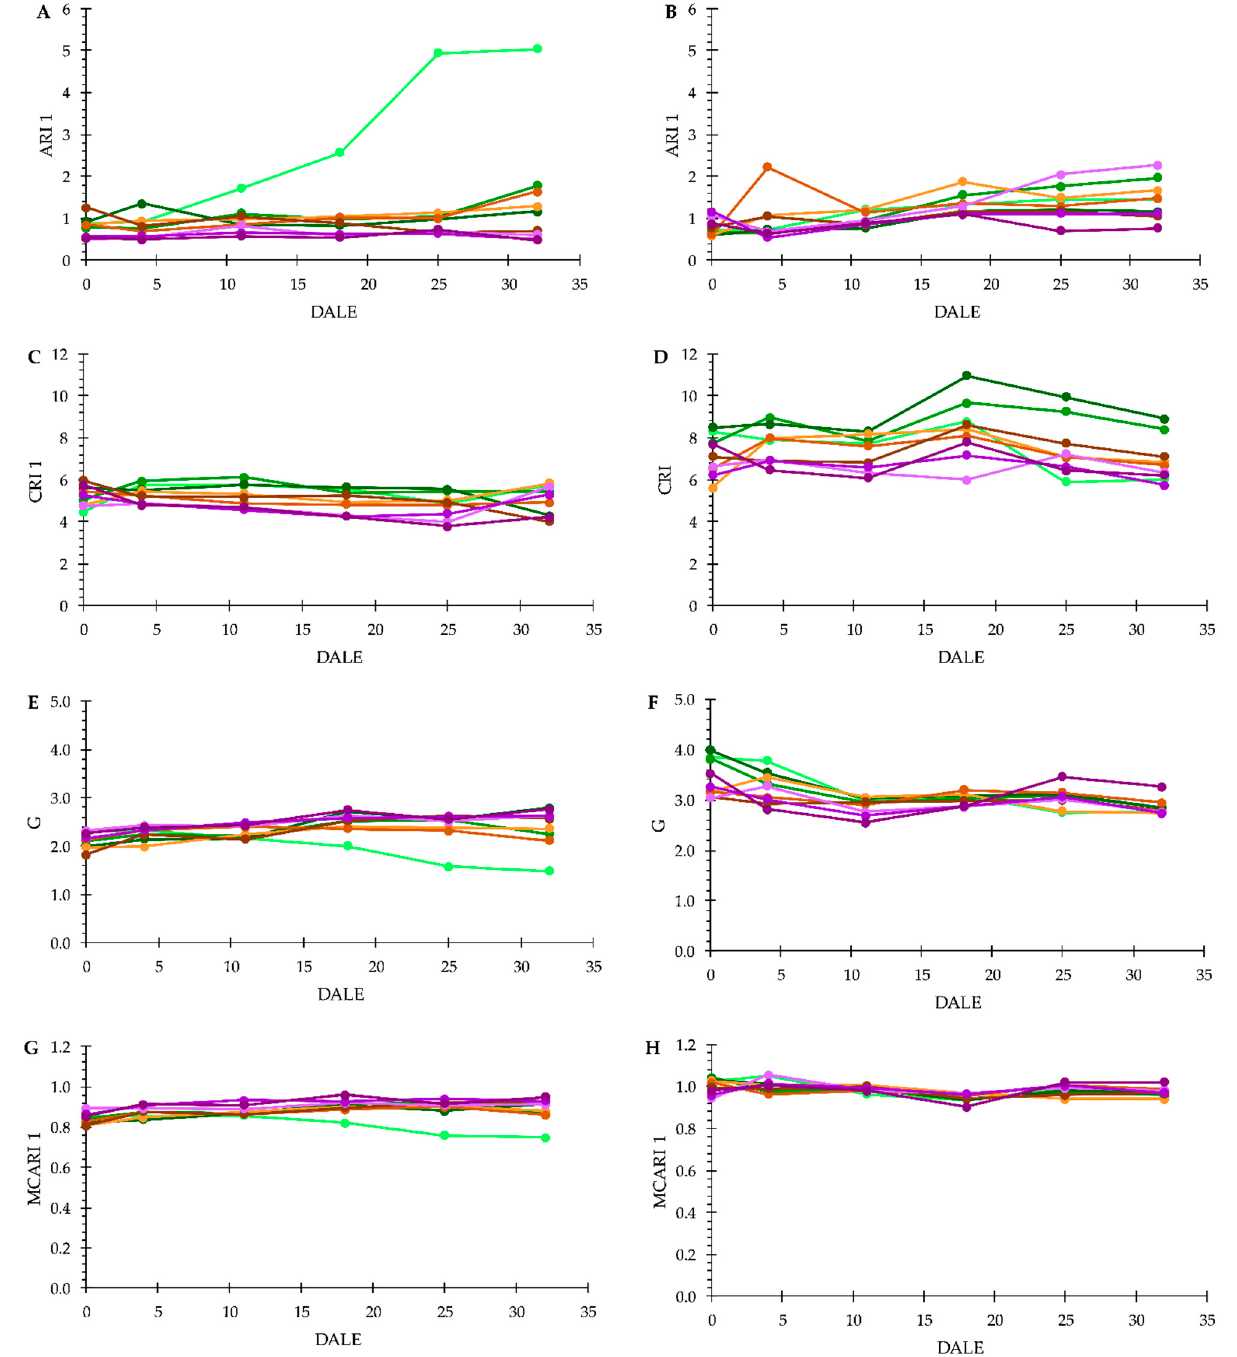
Figure 9. Pigment-based vegetation indices for H. macrophylla subsp. serrata cultivars (green: ‘Oamacha’, orange: ‘Odoriko Amacha’, purple: ‘Amagi Amacha’) under different shading conditions (dark coloring: full shade, medium coloring: partial shade, light coloring: no shade) in 2018 ( A , C , E , G ) and 2019 ( B , D , F , H ). Full display of significant differences is reported in the Supplementary Materials Table S5.